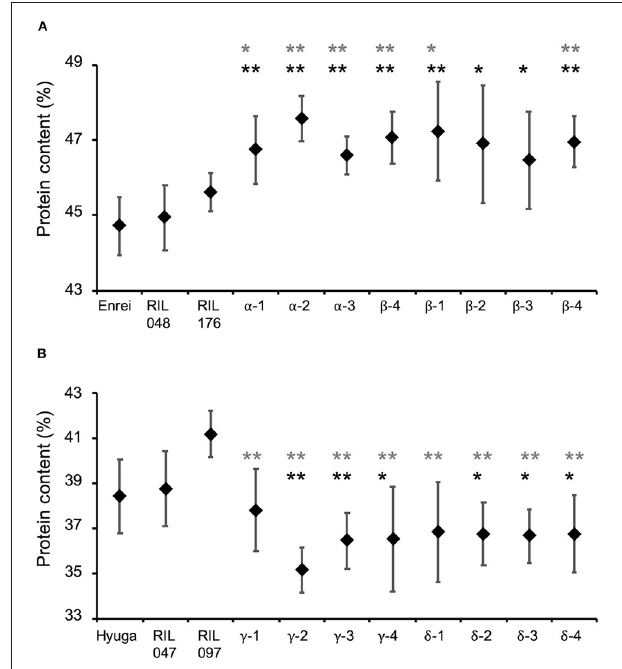
FIGURE 7 | Comparison of protein content of the validation lines with that of parental cultivars and parental recombinant inbred lines (RILs). Selected progeny of RIL048 × RIL176 toward higher protein content (A) and that of RIL047 × RIL097 toward lower protein content (B) . Greek letters ( α − δ ) indicate identifiers for the cross combination. The same Greek letter with different numbers indicates lines developed from the same cross combination. Black diamonds and whiskers indicate mean protein content and standard deviation, respectively. Black and grey asterisks indicate the mean protein content of the validation lines were significantly higher than that of their parental lines RIL048 and RIL176 (A) or lower than that of RIL047 and RIL097 (B) based on one-sided Student’s t -test, respectively. *, p < 0.05; **, p <